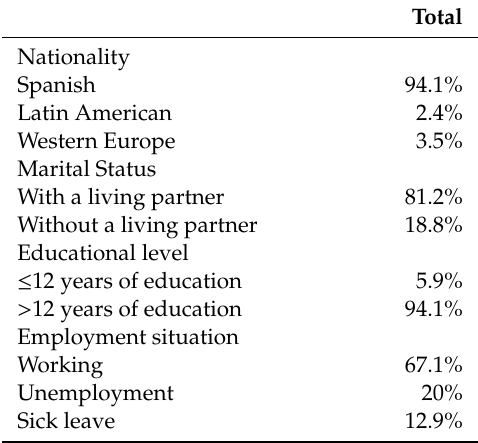
Table 1. Sociodemographic characteristics of the sample (N =